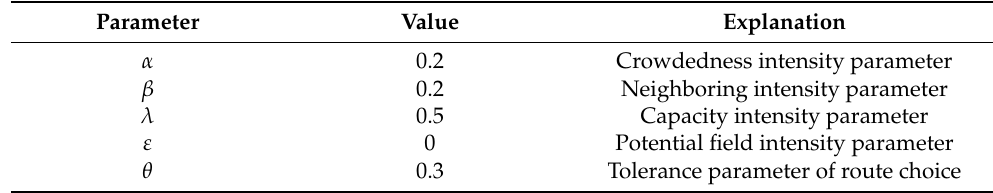
Figure 4. The study area is the core exhibition area of Emperor Qinshihuang’s Mausoleum Site Museum in Xi’an, China. Table 1. Parameters of the spatio-temporal cognitive